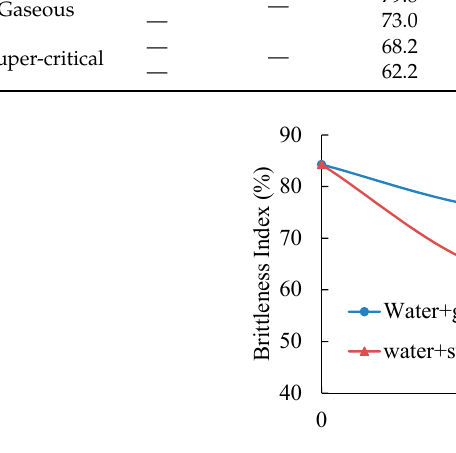
Figure 7. Variations of brittleness index for shale samples.